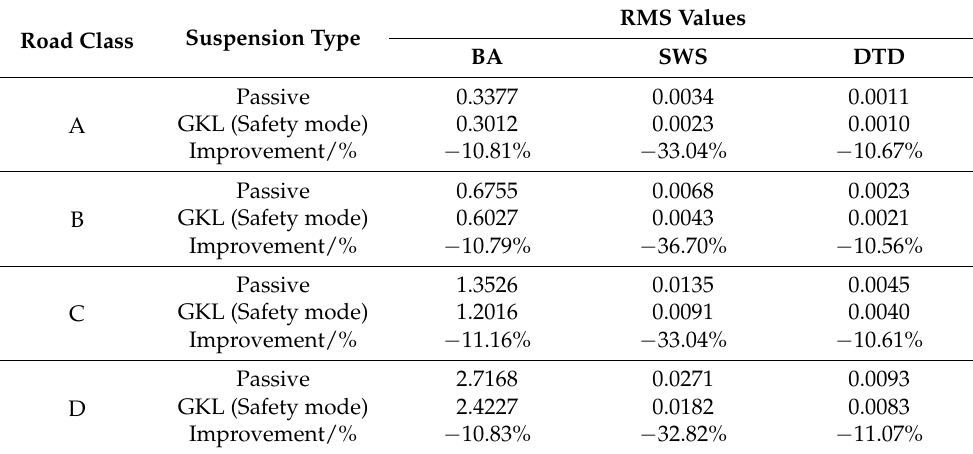
Table 13. RMS values and improvement rate of performance indexes for safety mode. Road